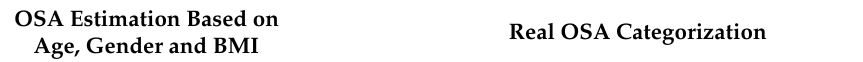
Table 5. AI-supported prediction of three-category OSA classification, based on age, gender and BMI (the table shows the number of cases per 100 patients and the percentage distribution of scores within each OSA category). OSA: obstructive sleep apnoea.